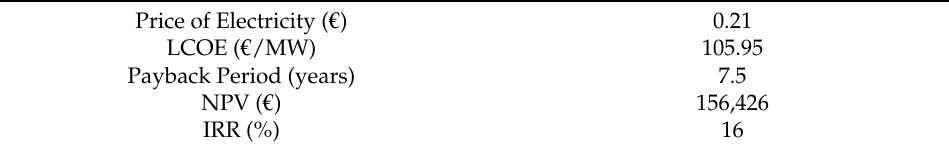
Table 12. Main results of the economic